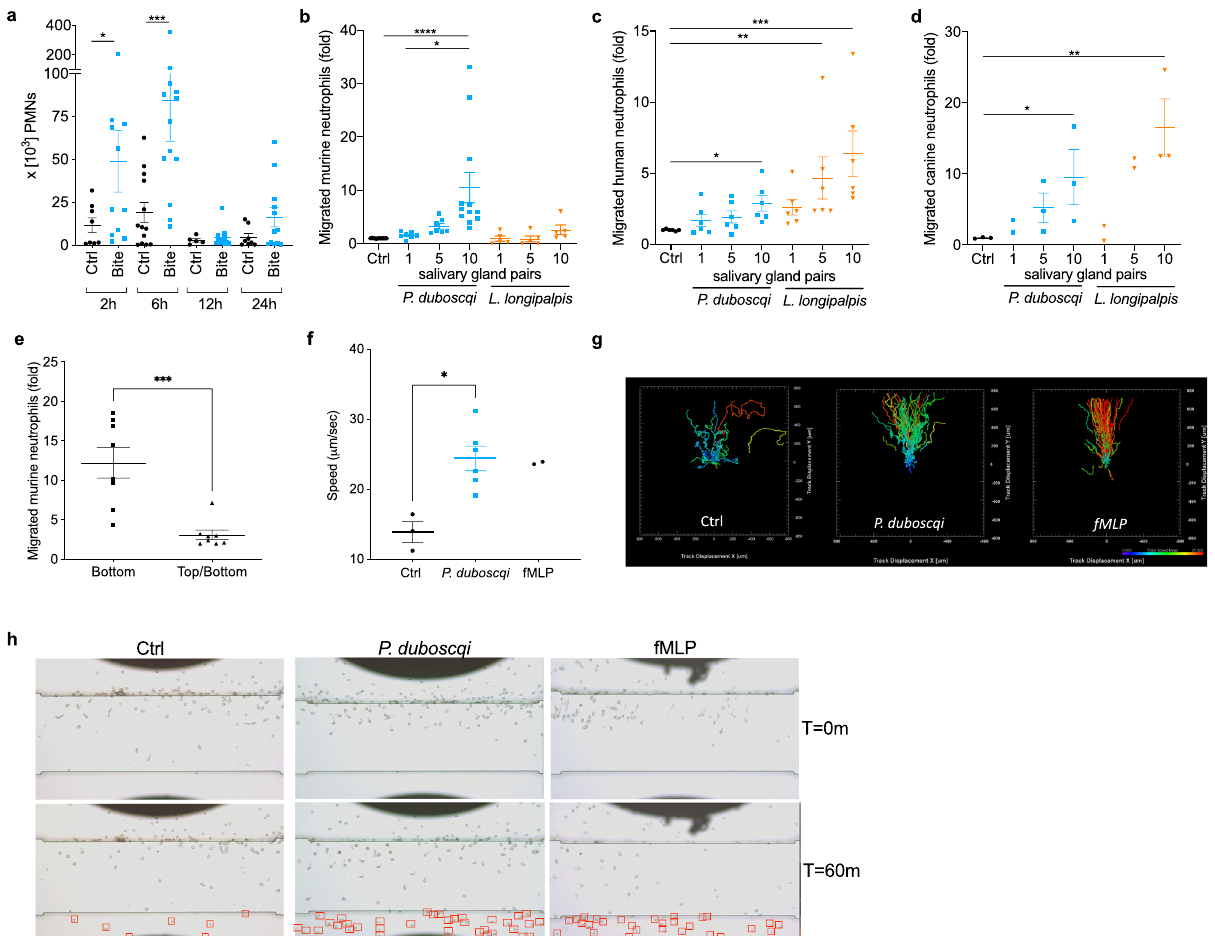
Fig. 1 P. duboscqi and L. longipalpis salivary glands homogenate contains neutrophil chemoattractants. a Flow cytometry analysis of in vivo neutrophils recruitment to C57BL6 mice ears. Mice ears were exposed to a single bite of P. duboscqi and neutrophil (Ly6G high /CD11b + /Ly6C l ° w/ − ) recruitment was analyzed after different time points. b , d Neutrophils were added to the top chamber of a transwell plate and different amounts of the sand fl y salivary gland homogenate were added to the bottom chamber. After 3 h, cells that migrated to the bottom chamber were quanti fi ed by DNA content. e Neutrophils were added to the top chamber of a transwell plate and ten pairs of P. duboscqi salivary glands were added to the bottom chamber or to both (top and bottom) chambers and run as in b – d . b , e Murine neutrophils were puri fi ed by magnetic negative selection from C57BL/6 bone marrow cells. c Human and d canine neutrophils were puri fi ed from peripheral blood of healthy donors by density gradient. f – h Validation of sand fl y salivary gland homogenate driven human neutrophil recruitment using EZ-TAXIScan assay. N-Formylmethionyl-leucyl-phenylalanine (fMLP) was used as a positive control. f , g Chemotaxis outcomes were analyzed by Imaris. f Chemotaxis mean speed was computed as the total path length divided by time. g Each track is plotted from the central point and shows XY displacement. h Still images show neutrophils at two different time points ( T = 0 m and T = 60 m). Red squares show migrated neutrophils at the bottom of the chamber. Data are presented as means ± SEM. a , e – g Cumulative results of two independent experiments. b – d Cumulative results of 3 independent experiments. a n = 8, 11, 13, 13, 5, 11, 8, 12; * P = 0.0343; *** P = 0.0003. b n = 12, 7, 7, 12, 5, 5, 5; * P = 0.017; **** P < 0.0001. c n